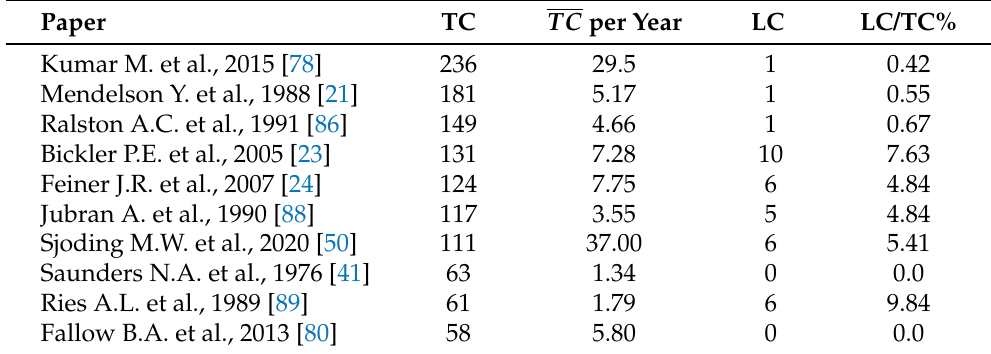
Table 5. Top 10 cited articles per author and year. TC column shows the total global citations, TC per year are the yearly average total citation, LC are local citations, while LC/TC% are the percentage ratio between local citations and global